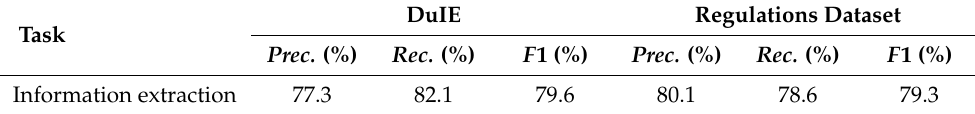
Table 2. Results of information extraction on DuIE and Regulations datasets.